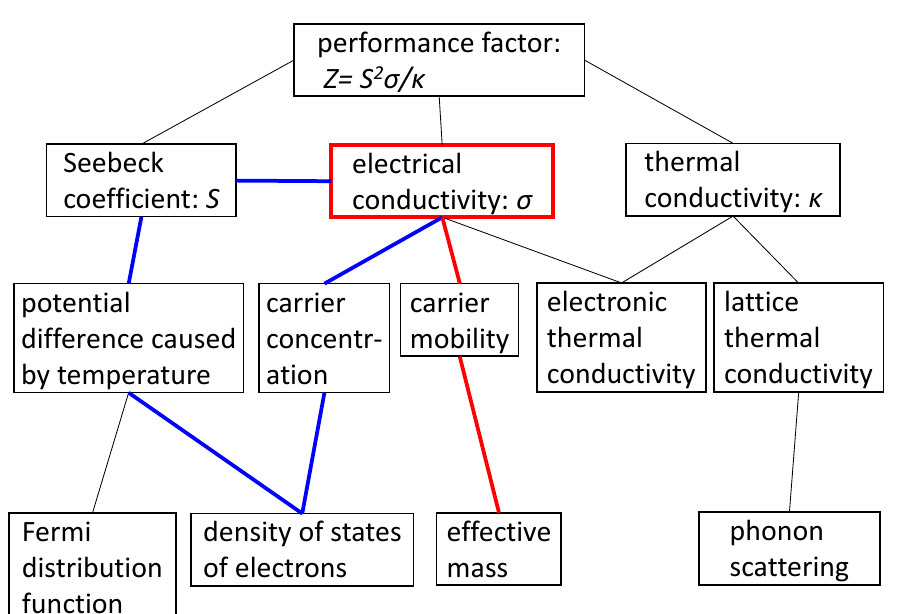
Figure 5. Relationships among various properties affecting the performance factor of thermoelectric materials.